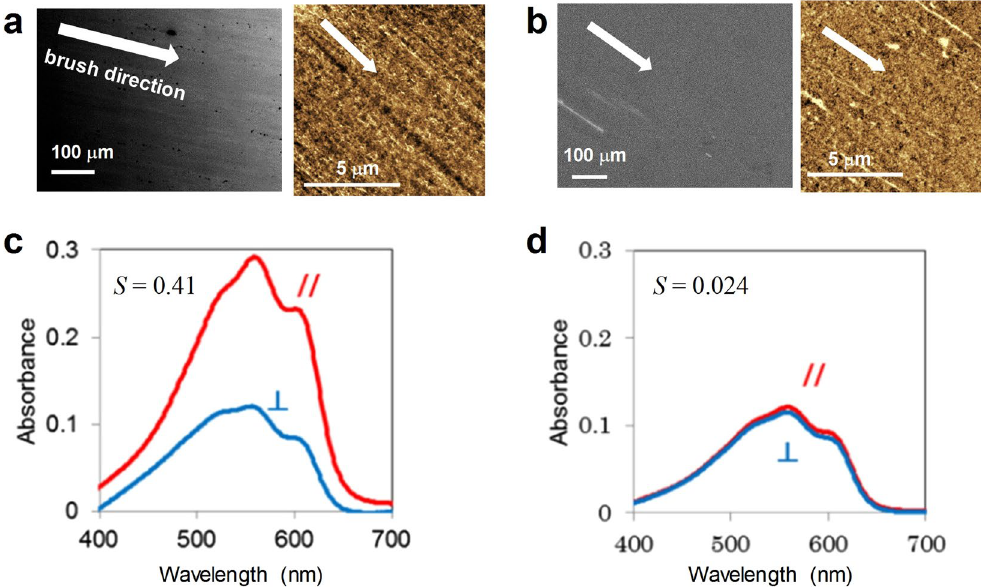
Figure 8. ( a , b ) SEM and AFM images, and ( c , d ) polarized absorption spectra. ( a , c ) P3HT film prepared on ITO brushed by velvet fabric as the soft friction transfer method. ( b , d ) P3HT film prepared on ITO brushed by PTFE plate as the conventional friction transfer method; ITO substrate was brushed with PTFE plate heated at 120 °C and P3HT solution was then spin-coated onto the substrate at room